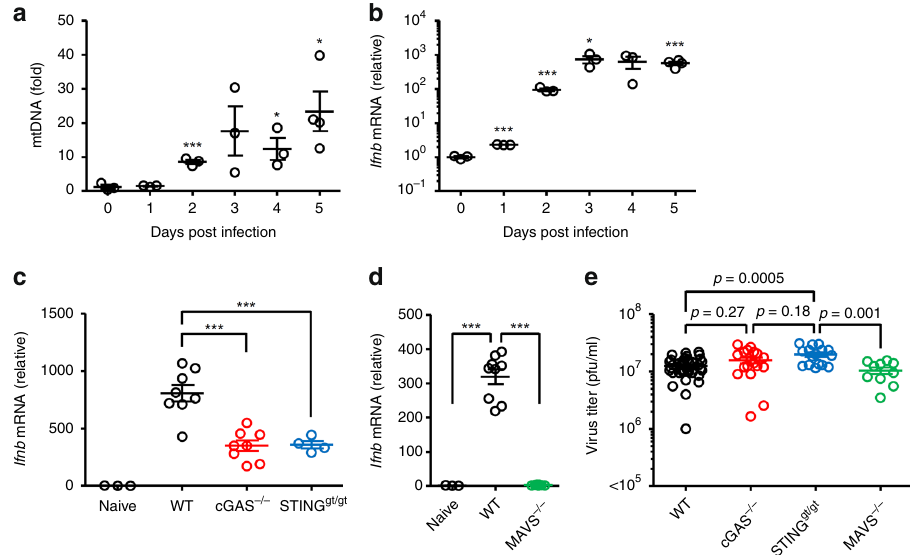
Fig. 9 Effect of cGAS or STING de fi ciency on in fl uenza virus replication in vivo. a , b WT mice were intranasally infected with 1,000 pfu of PR8 virus. The BAL fl uids ( a ) and lung tissues ( b ) were collected at indicated time points. DNA was extracted from BAL fl uids of mock- or in fl uenza virus-infected mice using QIAquick Nucleotide Removal kit (QIAGEN). Cytosolic mtDNA was assessed by quantitative PCR ( a ). Total RNAs were extracted from the lung tissue of mock- or in fl uenza virus-infected mice. IFN- β mRNA levels were assessed by quantitative PCR with GAPDH as an internal control ( b ). c , d WT, cGAS − / − , Sting gt/gt , and MAVS − / − mice were intranasally infected with 1000 pfu of PR8 virus. Lung tissues were collected at 4 d post infection. Total RNAs were extracted from the lung tissue and IFN- β mRNA levels were assessed by quantitative PCR with GAPDH as an internal control. e WT ( n = 37), cGAS − / − ( n = 18), Sting gt/gt ( n = 16), and MAVS − / − ( n = 10) mice were intranasally infected with 1000 pfu of PR8 virus. The BAL fl uids were collected at 5 d post infection and viral titers were determined by standard plaque assay. These data are from three independent experiments ( a – d ; mean ± s.e.m.) or pooled from four independent experiments ( e ; mean ± s.e.m.). * P < 0.05, *** P < 0.001; (one-way ANOVA and Tukey ’ s test). Source data are provided as